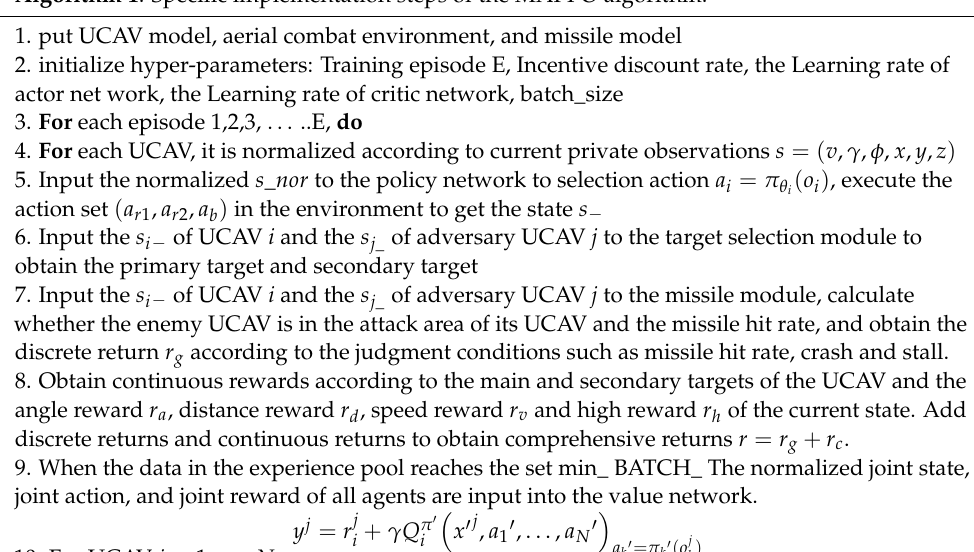
Algorithm 1 . Specific implementation steps of the MAPPO